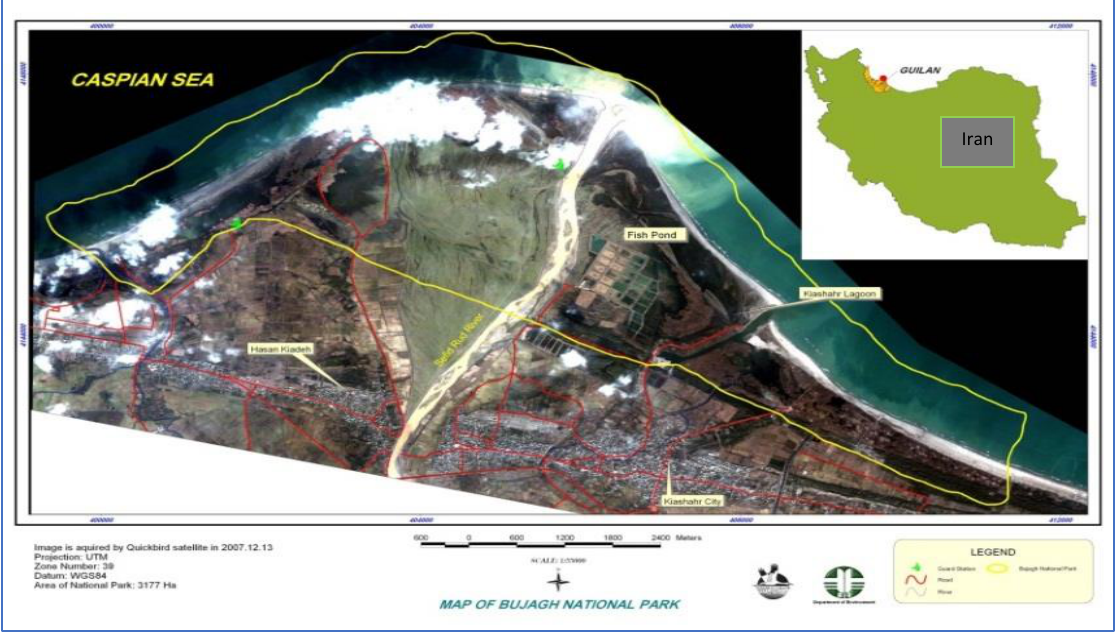
Fig. 1: Geographic location of the study area in Bujagh Wetland and National Park (Alemi safaval et al ., 2018)